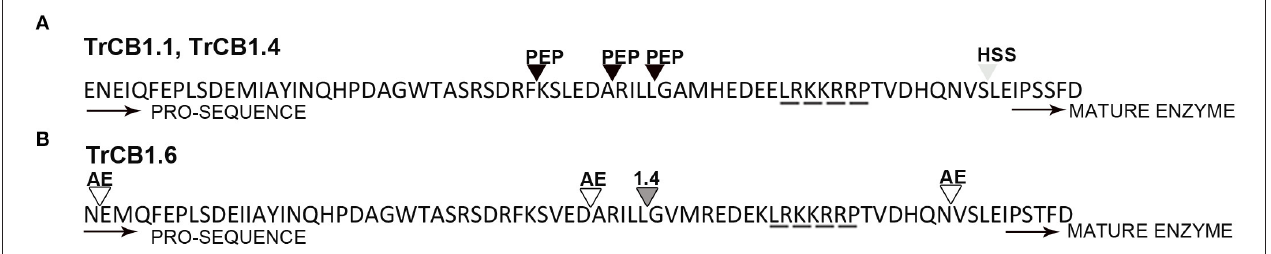
FIGURE 2 | Cleavage sites in the processed pro-sequences of TrCB1 forms. (A) cleavage sites determined by Edman degradation in pepsin-processed pepTrCB1.1 and pepTrCB1.4 (black triangles); cleavage site in TrCB1.4 auto-processing product resulted after 1-h incubation in the presence of heparin sodium salt (light gray triangle). (B) cleavage sites in rIrAE-activated TrCB1.6wt resulted after 1-h incubation at pH 5 (empty triangles); cleavage site in TrCB1.6wt after processing with pepTrCB1.4 (dark gray triangle). “Heparin-binding” (Horn et al., 2011) motif responsible for glycosaminoglycan binding to the pro-sequences is underlined by a dashed line.